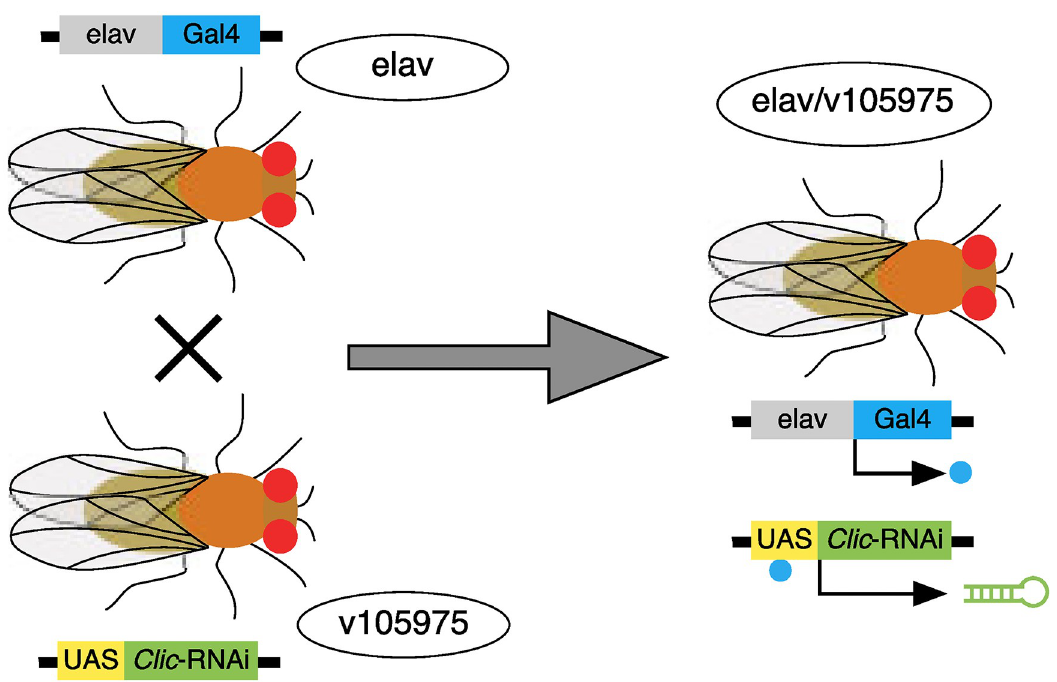
Fig 1. Overview of Clic knockdown approach. Schematic for cross to generate flies with neuron-specific expression of Clic RNAi (elav/v105975) used in these studies.